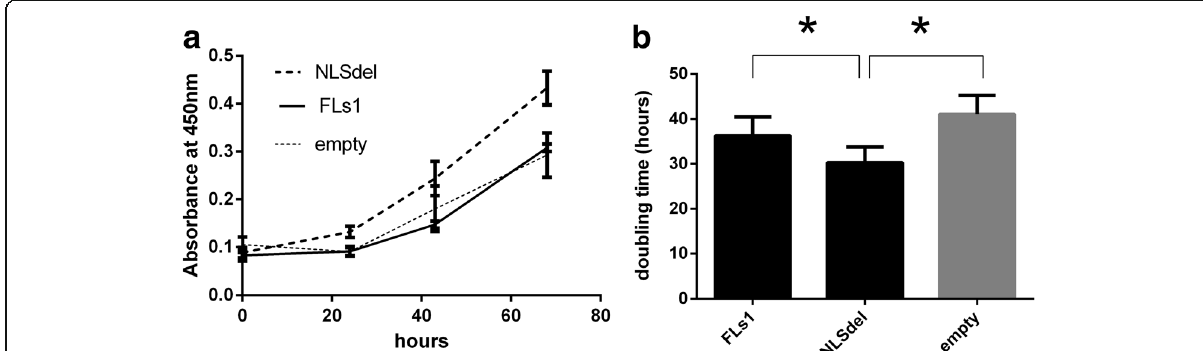
Fig. 1 Nuclear translocation of syndecan-1 inhibits fibrosarcoma cell proliferation. a B6FS fibrosarcoma cells transfected with full-length (FLs1), syndecan-1 lacking the nuclear localization signal (NLSdel) and corresponding empty vector (empty) were seeded at a density of 3000 cells/well in 96 well plates and absorbance values were measured using WST-1 proliferation assay. Symbols represent the mean±SD ( n =3). Cell proliferation increased when the nuclear translocation of syndecan-1 was impaired in the NLS deleted construct ( p =0.018). b Doubling time of cells transfected with different constructs shows that NLSdel grows faster while the difference between FLs1 and control is not significant. Bars represent the average of three independent experiments ±SD. * p <0.05, based on the paired t-test